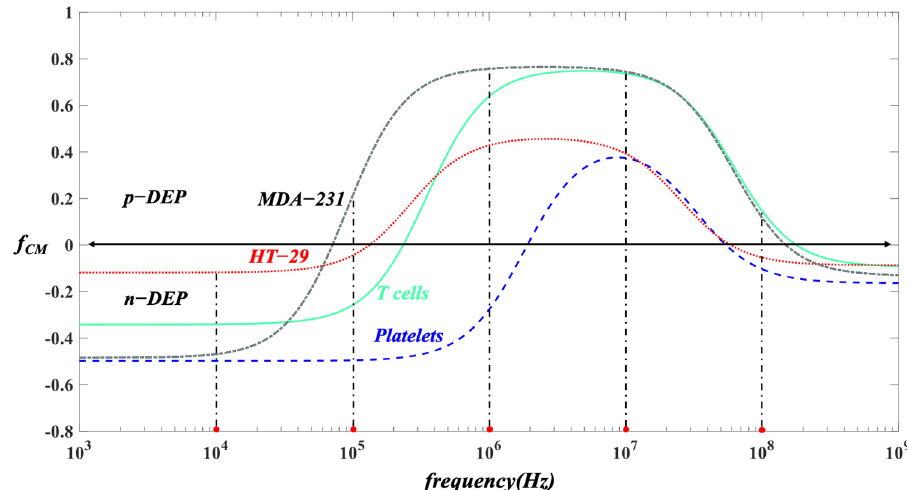
Figure 6. Prediction of f CM values for HT-29 (red dash line), T cells (solid green line), and platelets (blue dash line) varying with the electric field frequency.